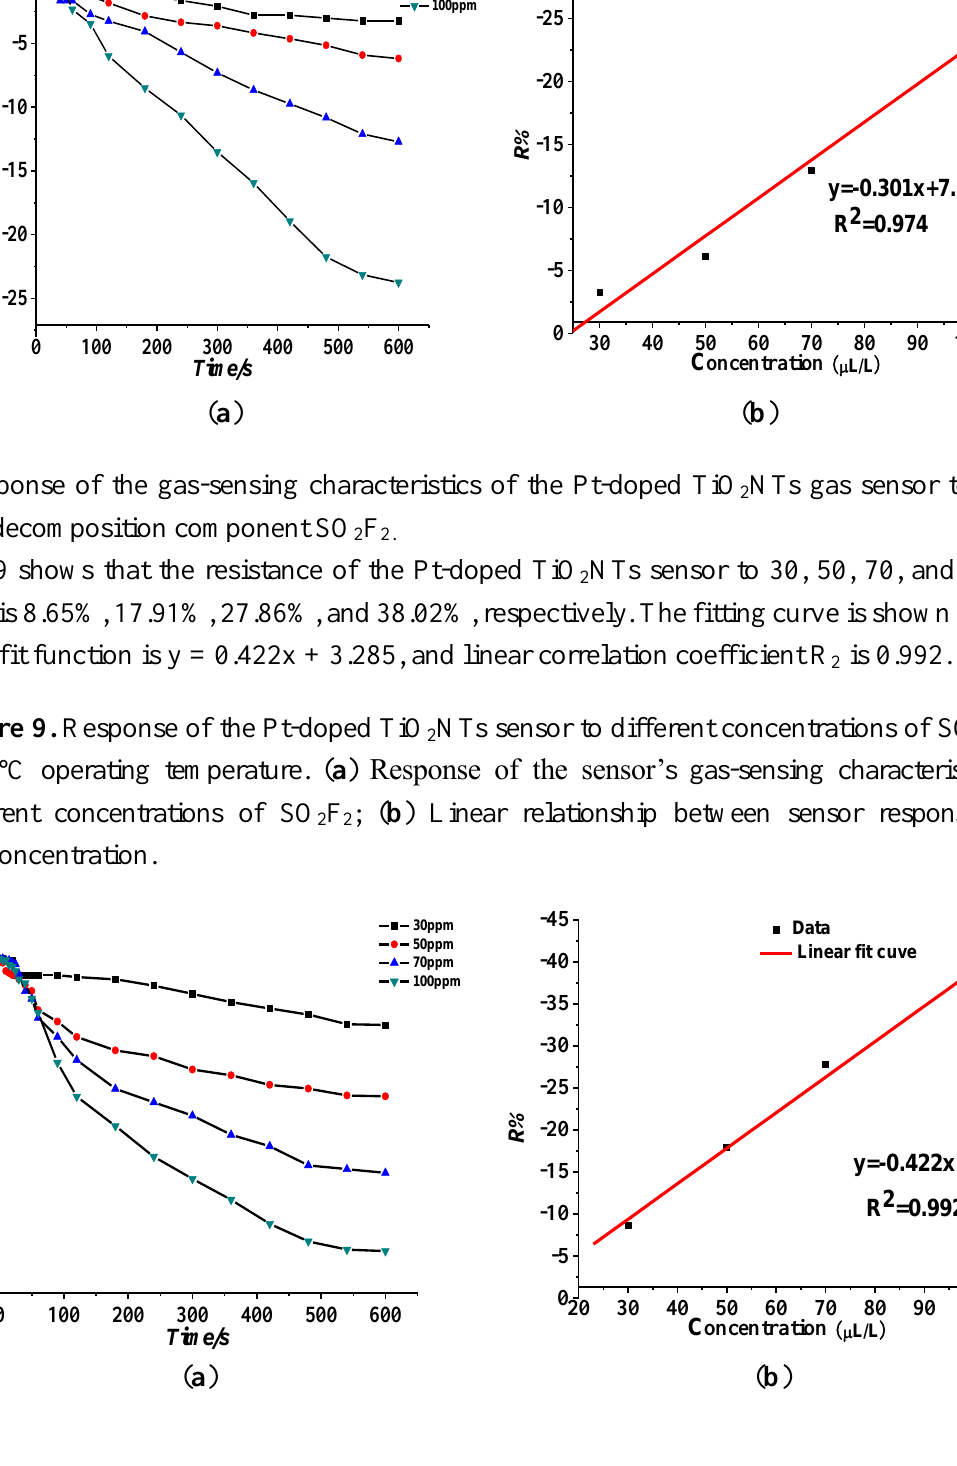
NTs sensor to different concentrations of SOF 2 ; ( b ) Linear relationship between sensor response and 2